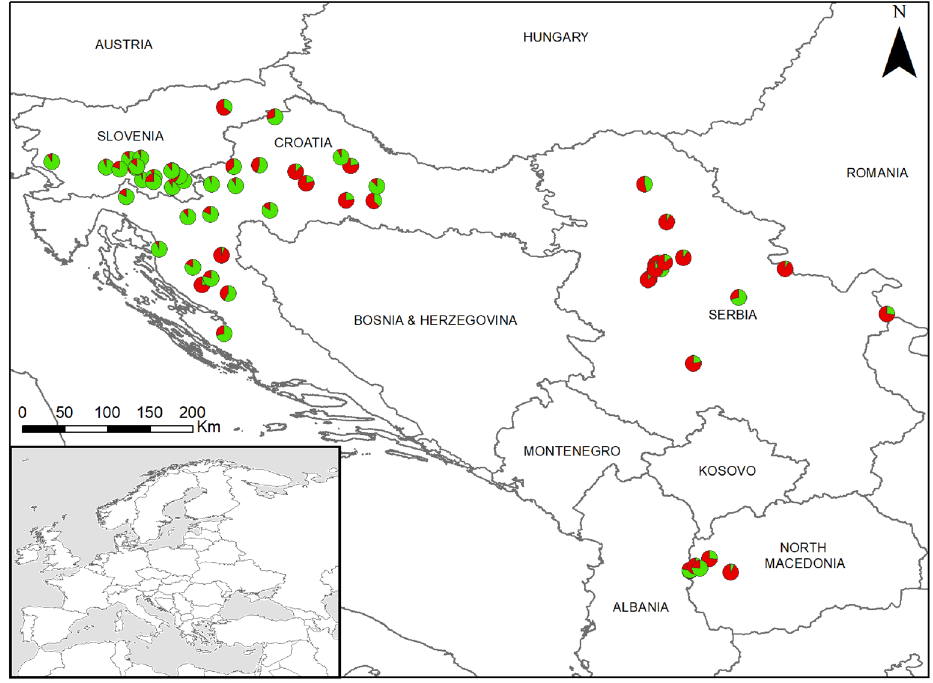
populations into two clusters (K = 2; see also Fig. 1b).